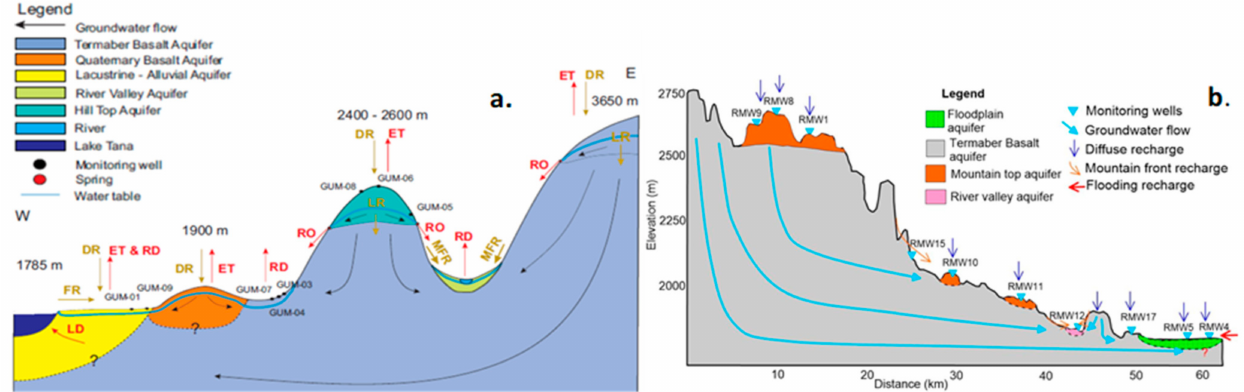
Figure 8. Hydrostratigraphical model for Gumara river catchment ( a ) (not to scale), and for Rib ( b ) with the different recharge/discharge mechanisms from the Guna shield mountain chain to the Lake Tana (after Van Landtschoote [64] and Getenet [43]), (DR = diffuse recharge, MFR = Mountain Front Recharge, LR = Leakage recharge, FR = Flooding recharge, LD = Lake discharge, ET = Evapotranspiration, RD = River Discharge, RO = groundwater discharge from